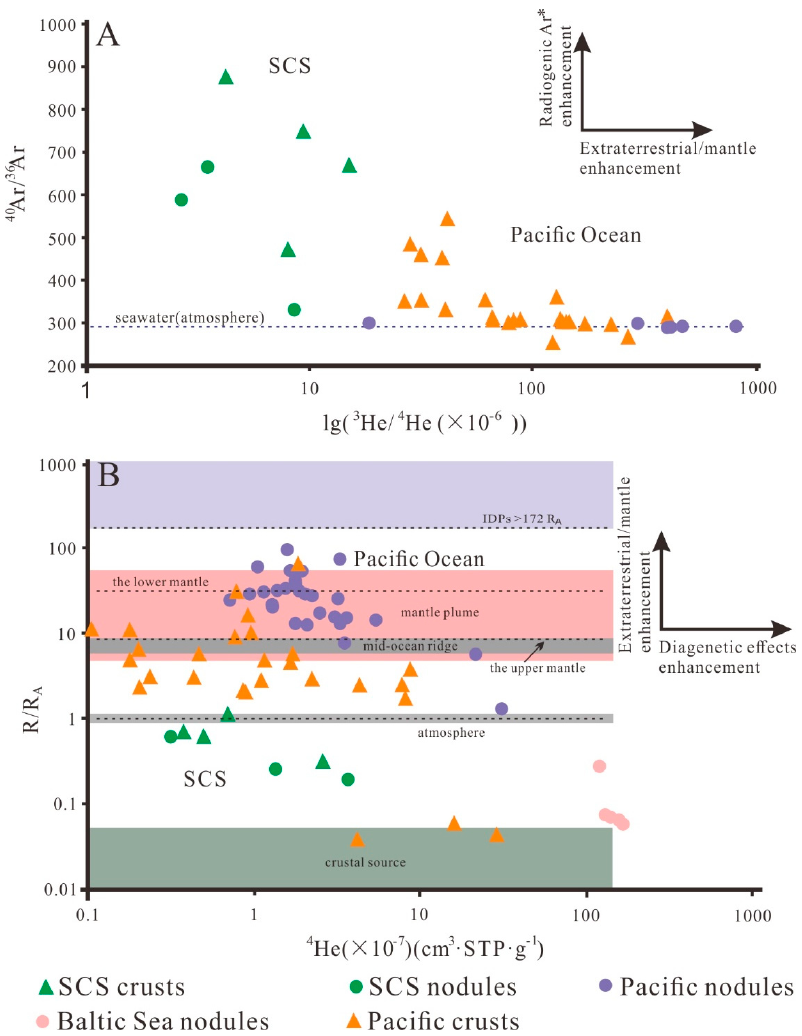
Figure 4. Plots of 3 He/ 4 He vs. 40 Ar/ 36 Ar ( A ) and 4 He concentration vs R/R A ( B ) of Fe-Mn crusts and nodules from the South China Sea and Pacific Ocean (SCS crusts and nodules data from this study; Baltic Sea nodules data from [65]; Pacific nodules data from [33,43,45]; Pacific crusts data from [43,47–50]).